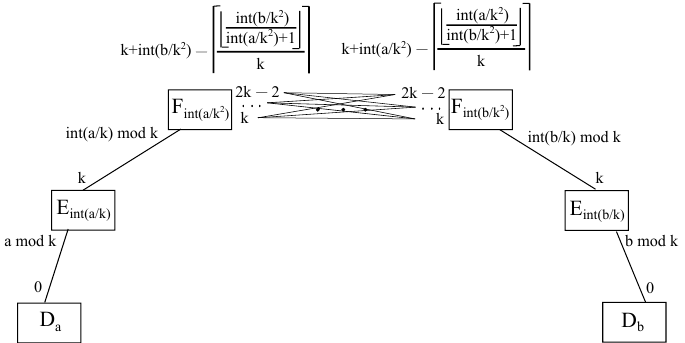
Figure 12. Schematic diagram for full mesh interfog